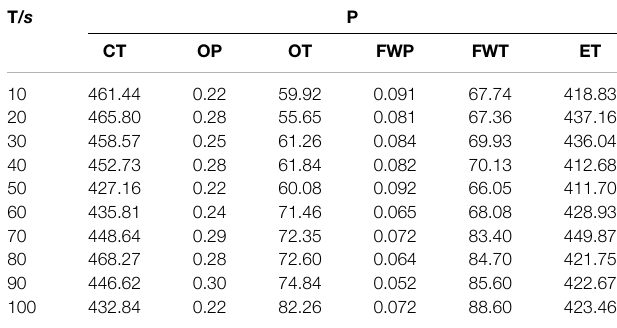
TABLE 5 | Collected data of engine equipment from normal operation to fault 2.